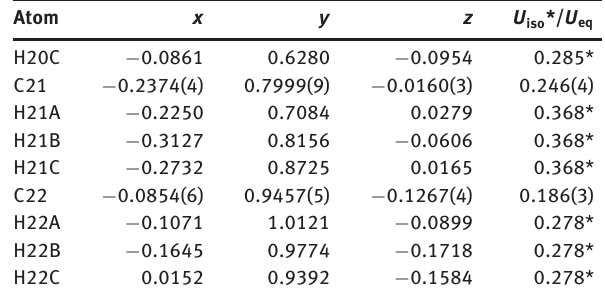
Table 2: Fractional atomic coordinates and isotropic or equivalent isotropic displacement parameters (Å 2